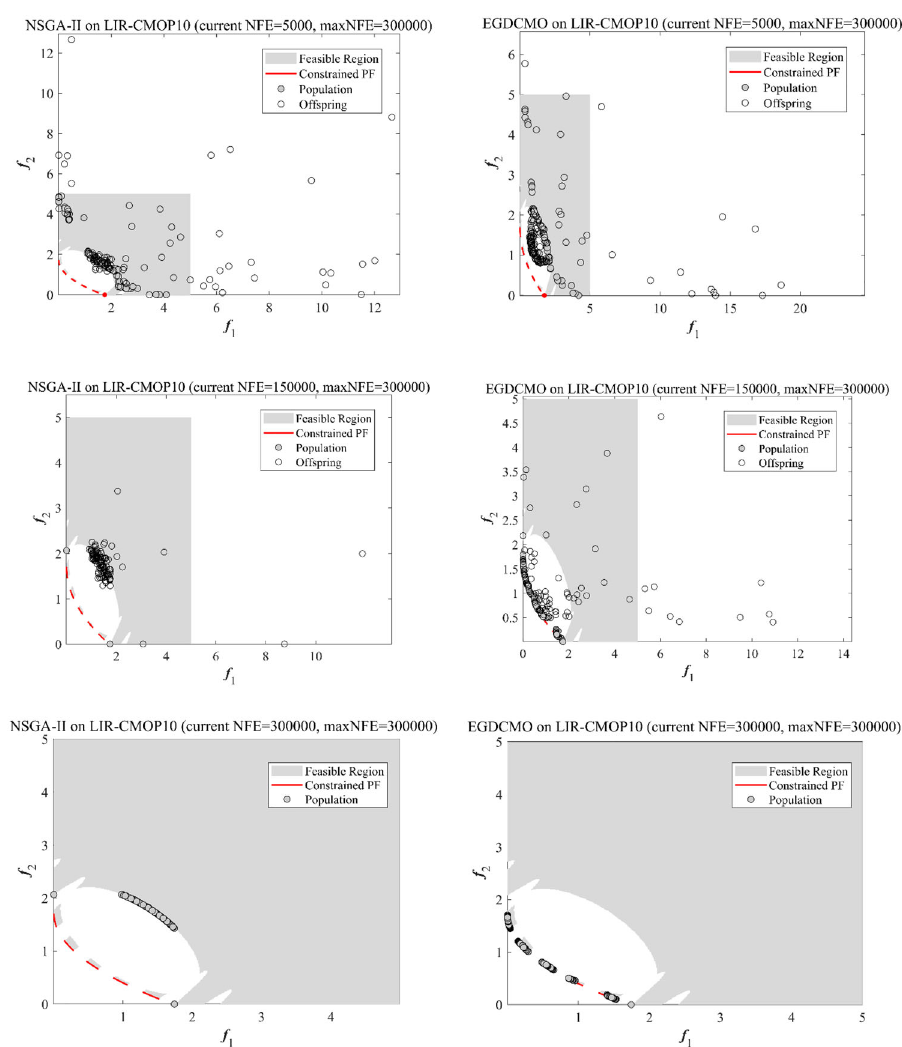
Fig. 6 Populations in the early, middle, and last generations